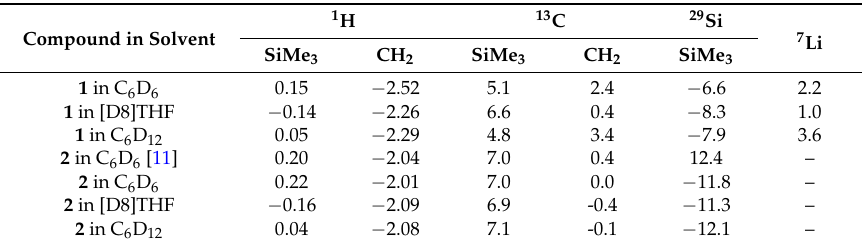
Table 2. 1 H, 13 C, 29 Si, and 7 Li NMR spectroscopic data of compounds 1 and 2 dissolved in C 6 D 6 , [D8]THF, and C 6 D 12 . The chemical shifts are given in ppm. Compound in